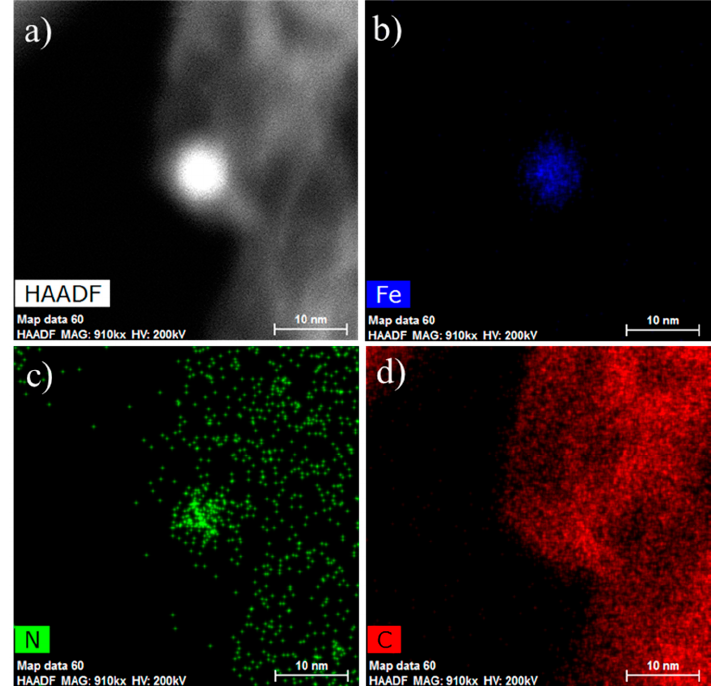
Figure 5. ( a ) High angle annular dark field ‐ scanning transmission electron microscope (HAADF ‐ STEM) image of Fe ‐ N ‐ C catalyst, electron energy loss spectroscopy (EELS) mapping images of Fe ‐ N ‐ C catalyst ( b ) Fe, ( c ) N, and ( d ) C.